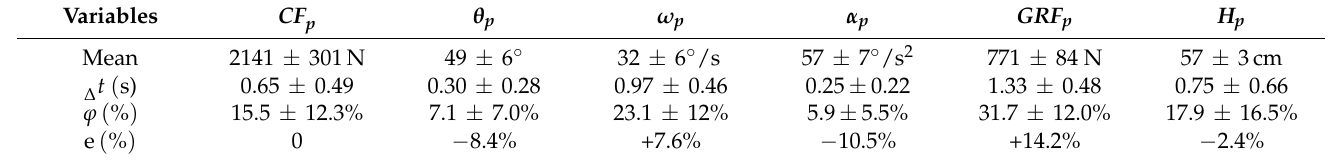
Table 2. Time lag ∆ t , normalized time lag ϕ ( % ) , and normalized time error (e ( % ) ) of each factor. Variables